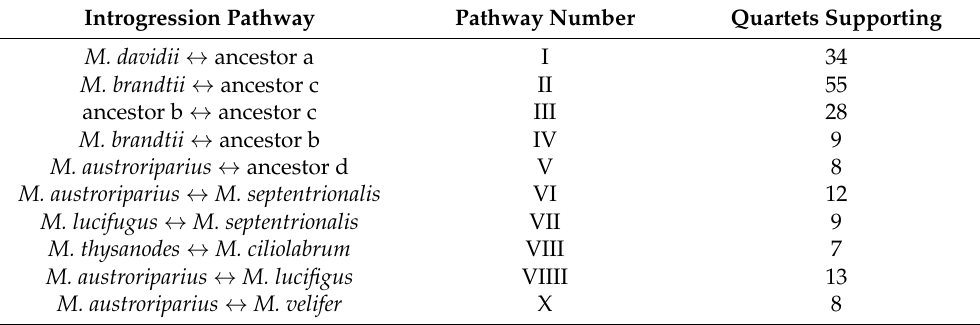
Figure 4. Visualizations of phylogenetic discordance among Myotis inferred from polymorphic Ves insertions. ( A ) Unrooted median joining network tree generated from all 10,595 loci. ( B ) Majority rule consensus tree illustrating the distribution of discordant signals in the dataset. Discordant Ves insertions (2+ state changes) are considered a phylogenetic signal for the common ancestor for all taxa carrying the insertions. Counts on the tree indicate the number of synapomorphies coalescing at that node. For nodes without counts, all insertions within that clade alone had fewer than 2 state changes and did not qualify as discordant. The colors and order of species is the same in B and C. ( C ) Characterization of 3044 discordant insertions. The black bars on the left show the number of discordant insertions present in each species. The dot matrix indicates the synapomorphic patterns, with each pattern represented by a vertical line with dots indicating presence of the insertion in that species. Colors in the dot matrix correspond to the node of coalescence for that insertion in B. The y-axis above gives a count of times that pattern occurred among all 3044 discordant loci. Only the top 20 most prevalent patterns are shown on this graph. See text for additional information. Table 2. Proposed introgression pathways within Myotis based on 183 quartets showing significant frequency deviations from expectations under